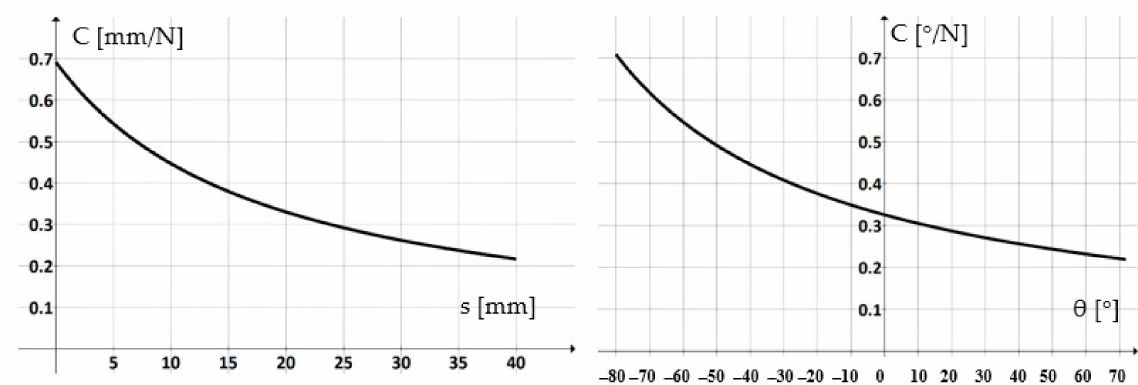
Figure 12. Variation of compliance versus the axial contraction of the pneumatic muscle and the flexion/extension angle of the